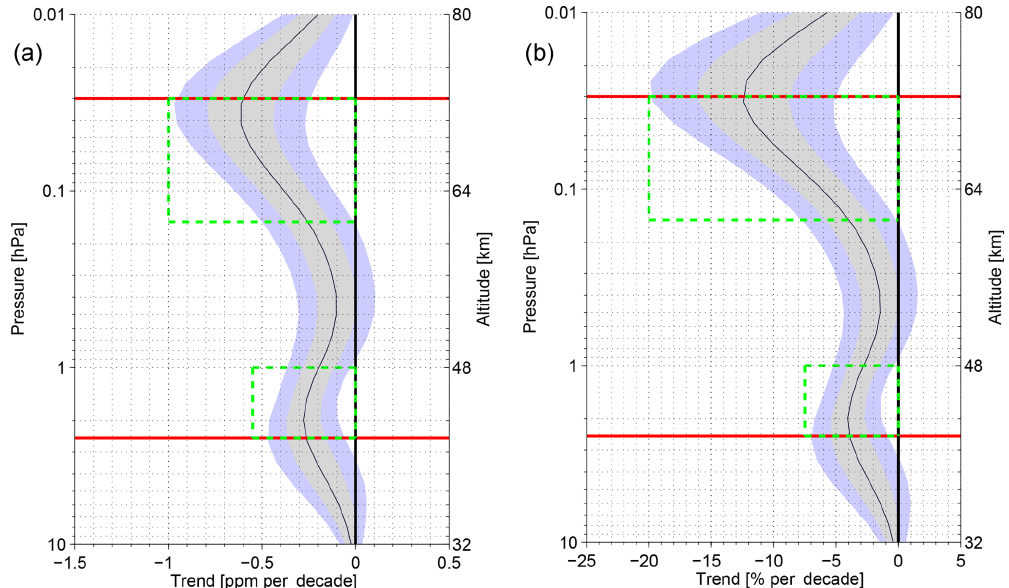
Figure 6. Estimated water vapor trend profile in parts per million (ppm) per decade (a) and percent (%) per decade (b) , for the time period between April 2007 and May 2018, observed by the MIAWARA instrument at the Zimmerwald observatory close to Bern, Switzerland. The black line represents the trend profile; the grey and violet shaded areas represent the 1 σ and 2 σ uncertainties of the trend estimate. The green boxes show where the trend is statistically significant on the 95% confidence level. The horizontal red lines mark the pressure range (0 . 03–2 . 5hPa) where the MIAWARA data is to ∼ 80% a priori